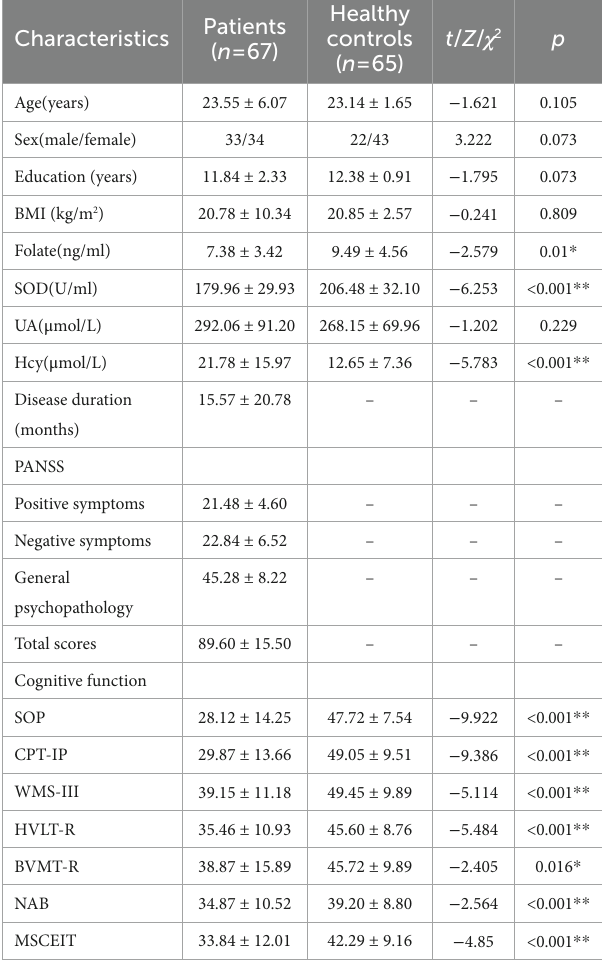
(Supplementary Table S1).Within the patient group, serum levels of SOD showed a significantly positive correlation with fimbria volume ( r = 0.360, p = 0.003); serum levels of folate showed a significantly positive correlation with hippocampal fissure volume ( r = 0.286, p = 0.021); serum levels of UA showed significantly positive correlations with whole hippocampal volume ( r = 0.395, p = 0.001),